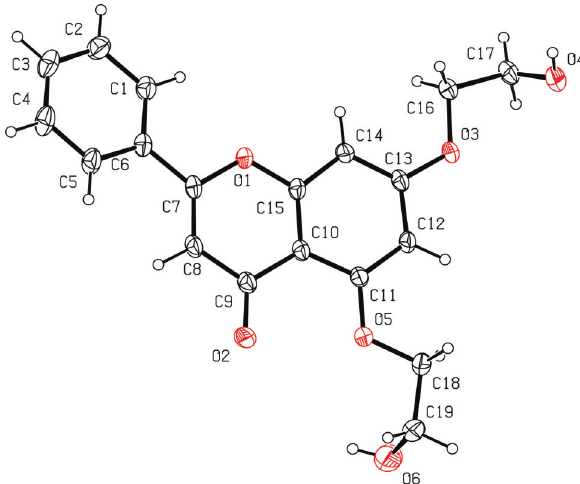
Table 1: Data collection and handling.